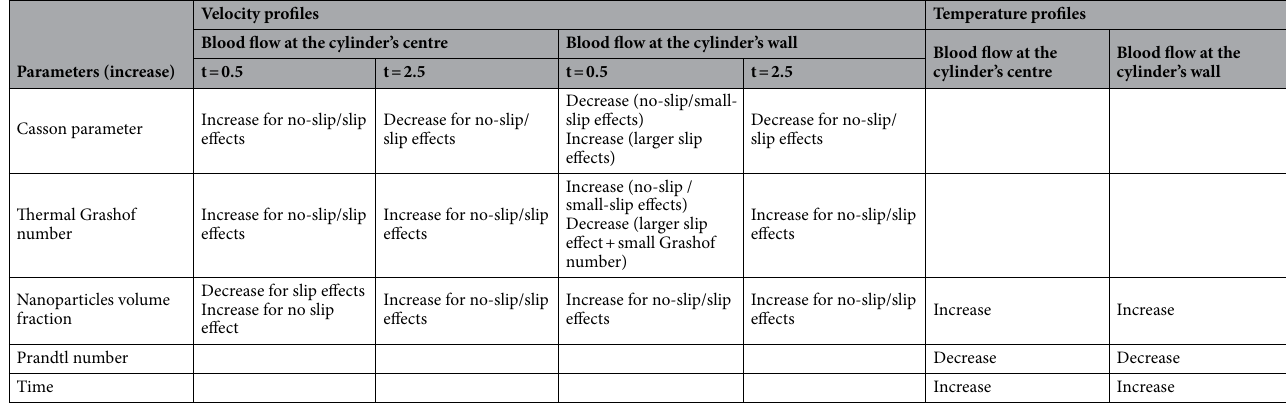
Table 2. Results comparisons for velocity and temperature